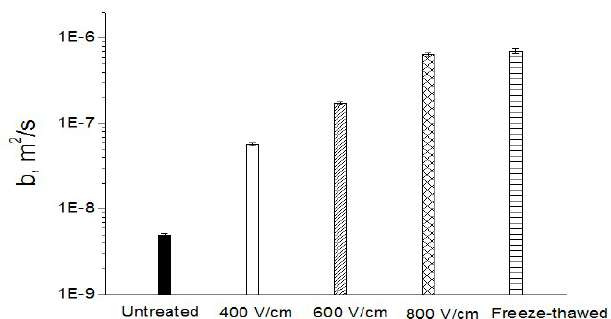
Figure 6. Coefficient for the untreated, PEF treated, and freeze-thawed samples.